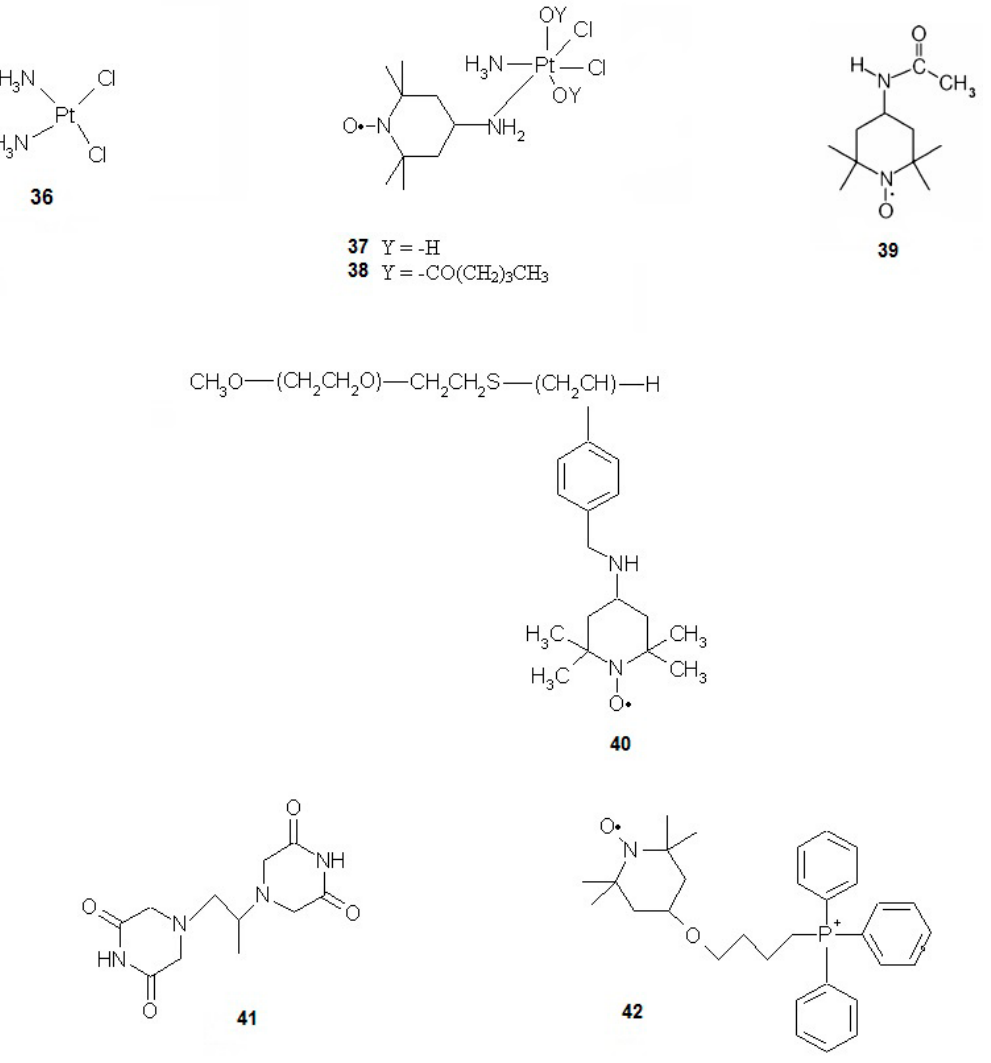
Figure 10. Spin-labelled cis -platin derivatives and other anticancer agents: ( 36 ) cis -platin, ( 37 ) Nx-Pt I, ( 38 ) Nx-Pt II, ( 39 ) Tempace, ( 40 ) PEG-b-PMNT, ( 41 ) dexrazoxane and ( 42 ) Mito-Tempol-4.